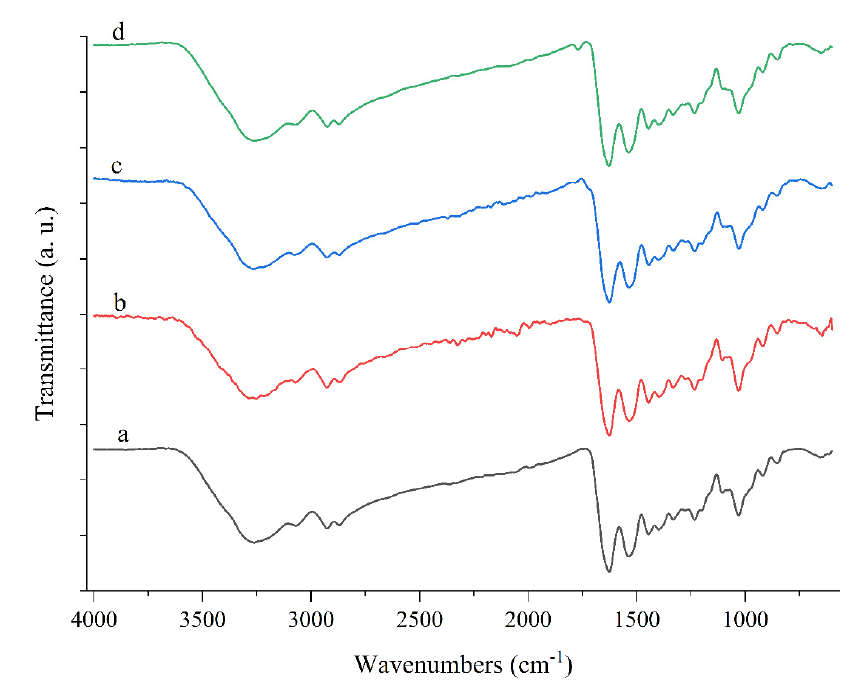
Figure 5. ATR − FTIR spectra of ( a ) gelatin, ( b ) gelatin/chitosan nanofibers, ( c ) G/CsNFs/Bas, and ( d ) G/CsNFs/SPAs films.